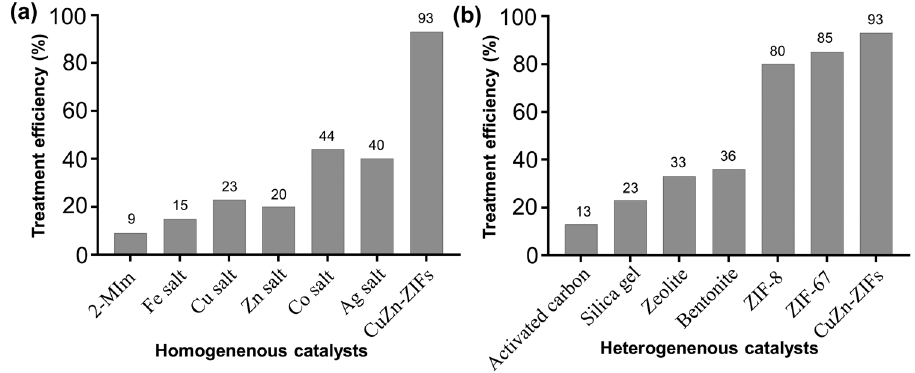
Figure 8: E ffi ciency of DBF degradation using CuZn - ZIFs in comparison with homogeneous catalyst and heterogeneous catalyst: ( a ) homogeneous catalysts and ( b ) heterogeneous catalysts. Catalysis: [ DBF ] = 30 ppm, [ H dosage = 10 mg, time = 60